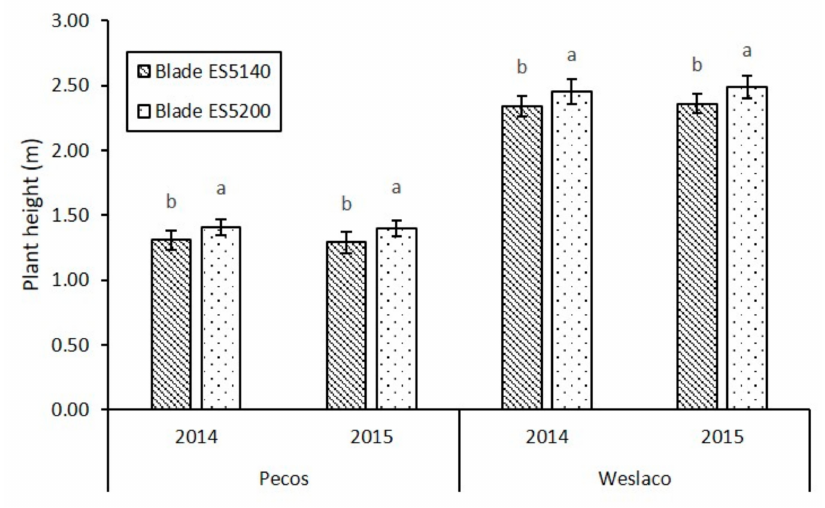
Figure 5. Plant height of the two energy sorghum cultivars at harvest in the two growing